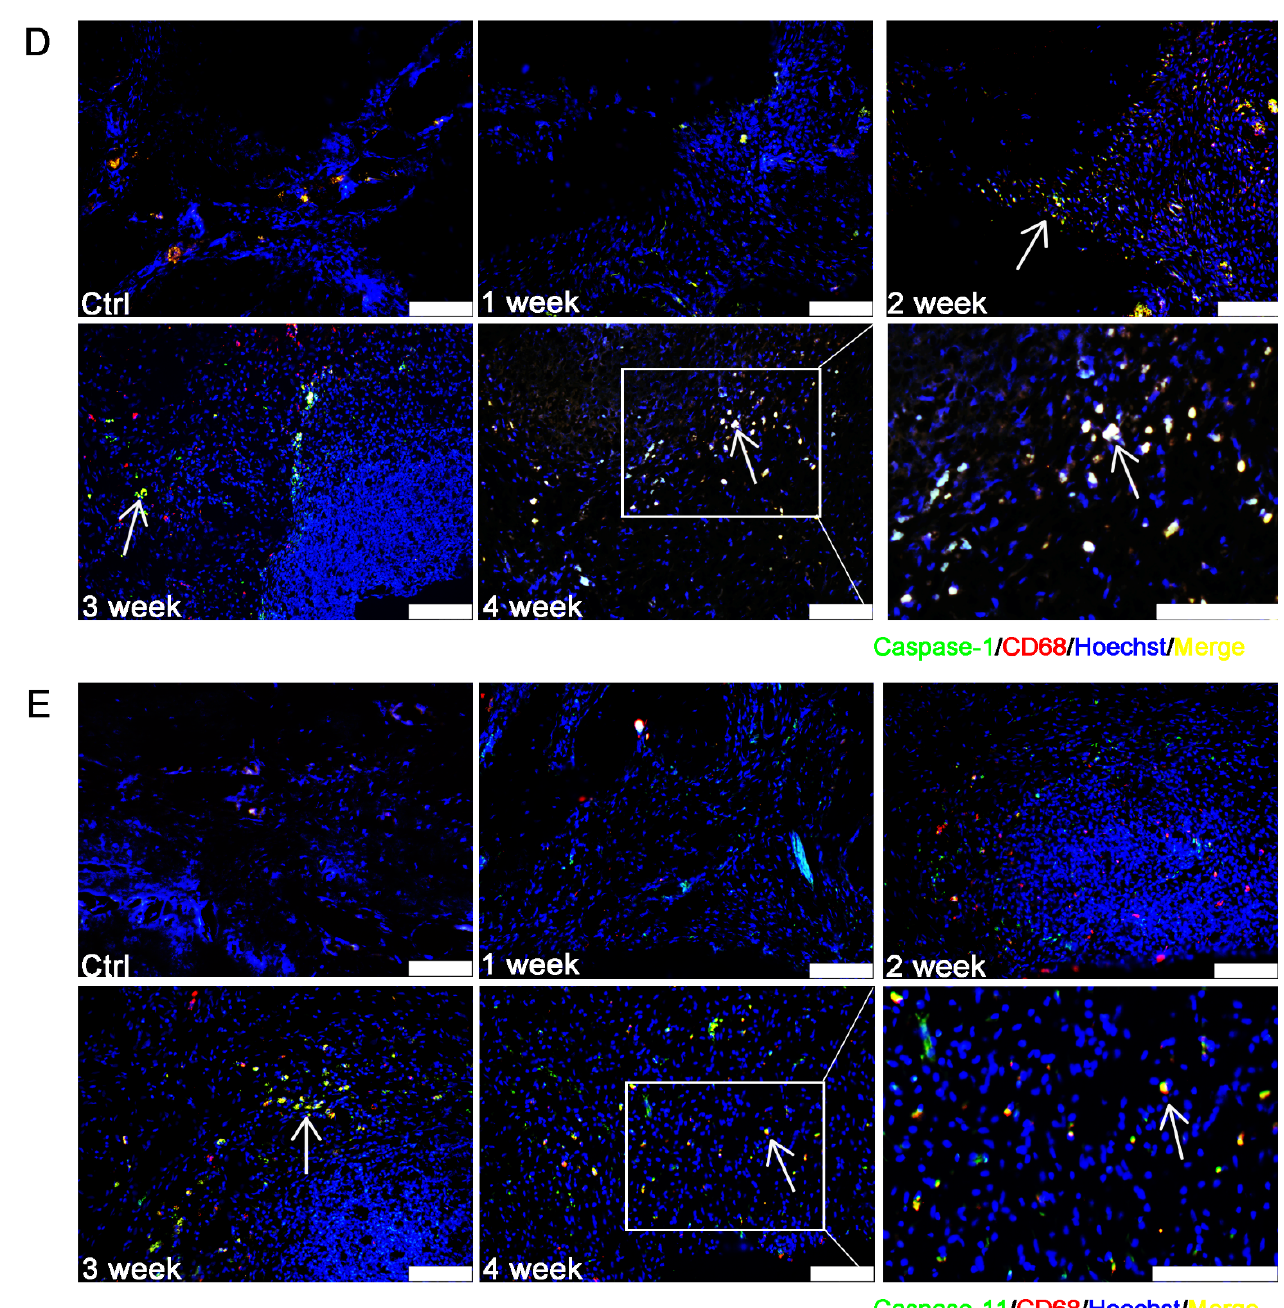
Figure 3. Pyroptosis was detected in EAP. ( A ) The HE staining of EAP. The apical lesion developed gradually (Bar, 100 μm). ( B ) Triple labelling of caspase-1 (green), caspase-11 (red) and Hoechst (blue) was performed by using immunofluorescence. The results showed that caspase-1 and caspase-11 overlapped (Bar, 100 μm). ( C ) TUNEL (green), caspase-11 (red) and Hoechst (blue) staining were performed using TUNEL staining and immunofluorescence. Dual labelling of TUNEL and caspase-11 showed that some caspase-11 + cells underwent pyroptosis (Bar, 100 μm). ( D , E ) Triple labelling of caspase-1/-11 (green), CD68 (red) and Hoechst (blue) was performed using immunofluorescence. The results showed that caspase-1 and caspase-11 were expressed in AP, especially in macrophages (Bar, 100 μm). Pyroptosis appeared in EAP as early as 1~2 weeks when apical lesions started to de- velop. Pyroptosis reached a high level after week 2. However, does pyroptosis influence